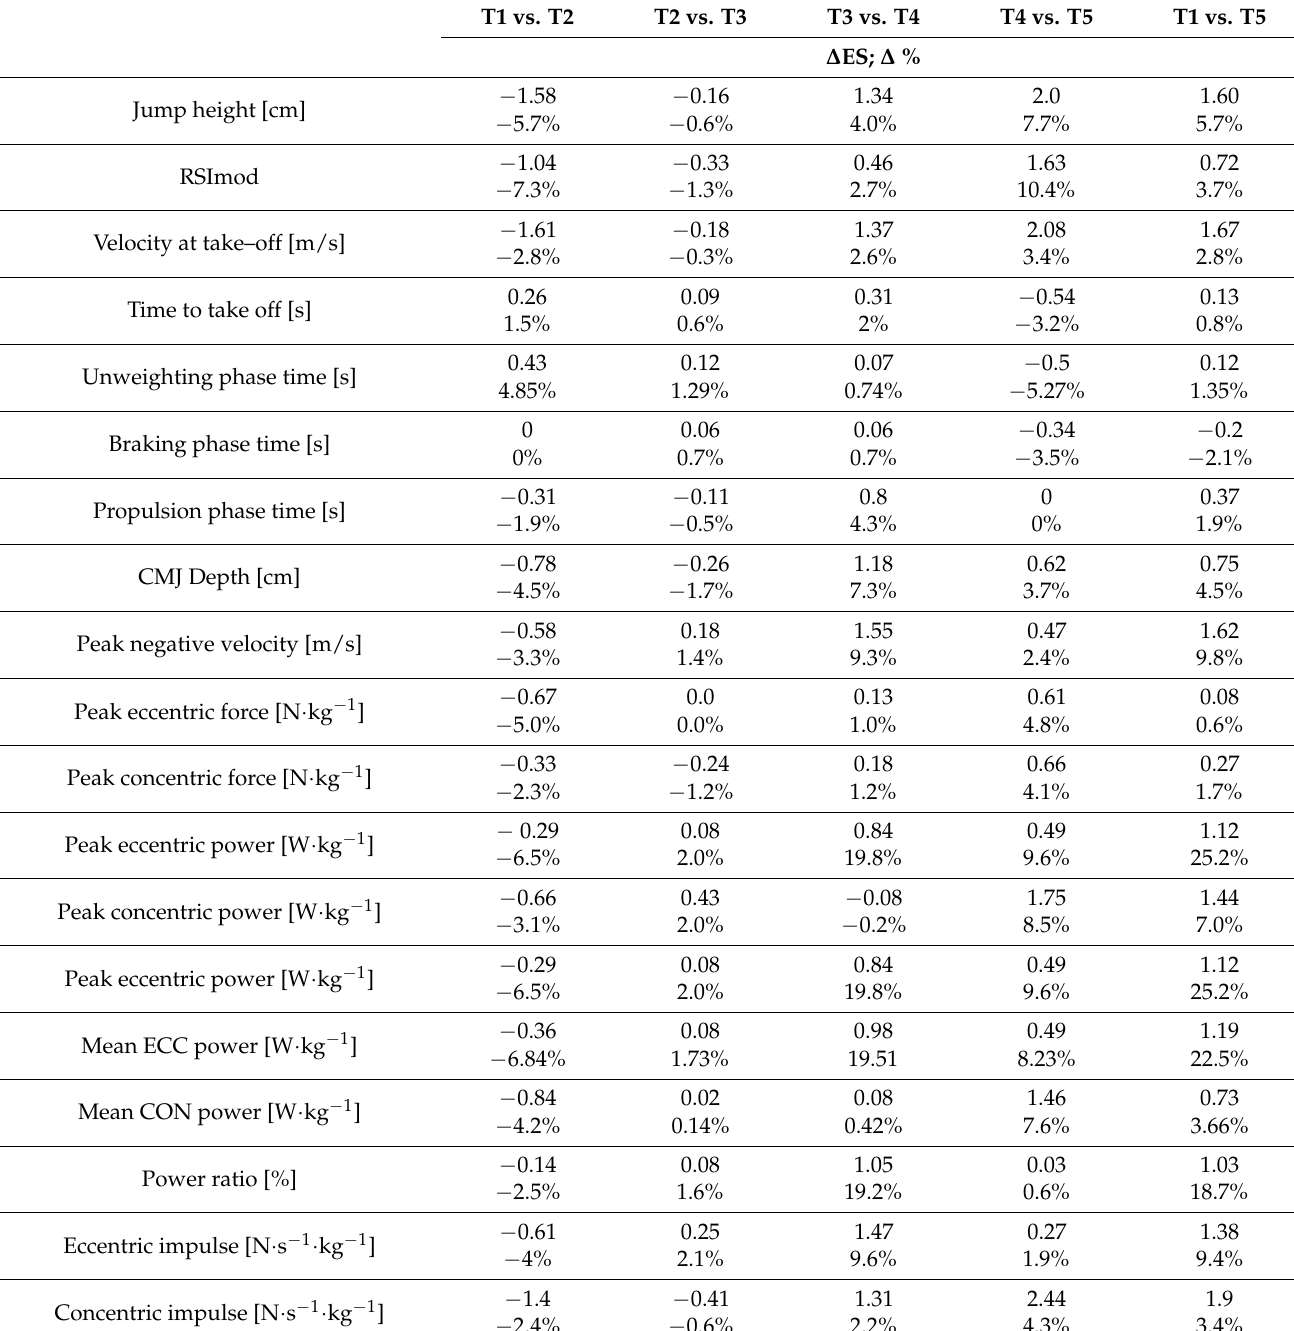
Table 9. Effect sizes and % change from CMJ test.